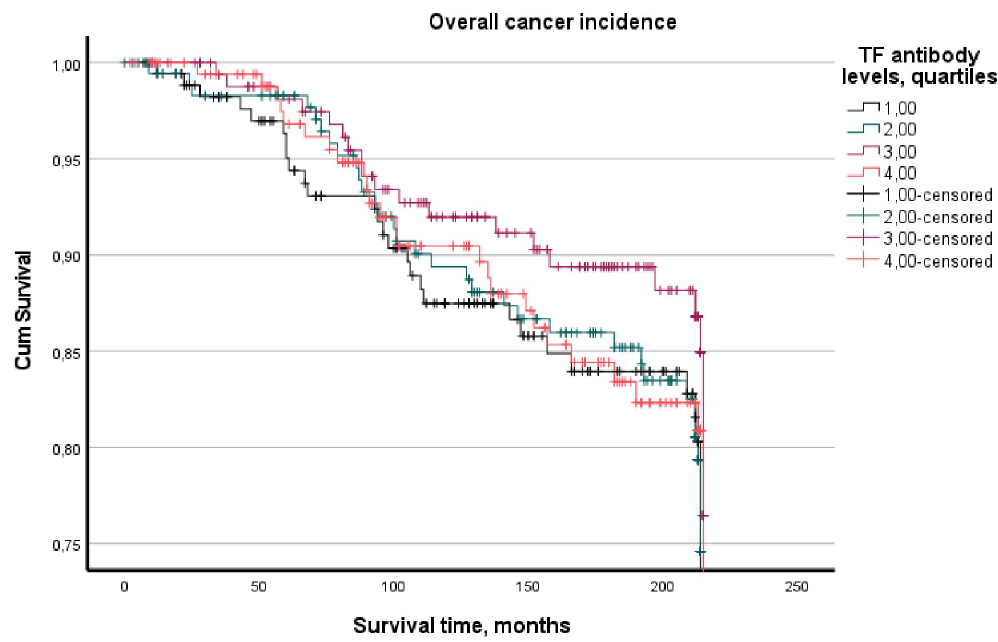
Fig 5. Overall cumulative cancer incidence stratified on quartiles of Tannerella forsythia antibody levels.